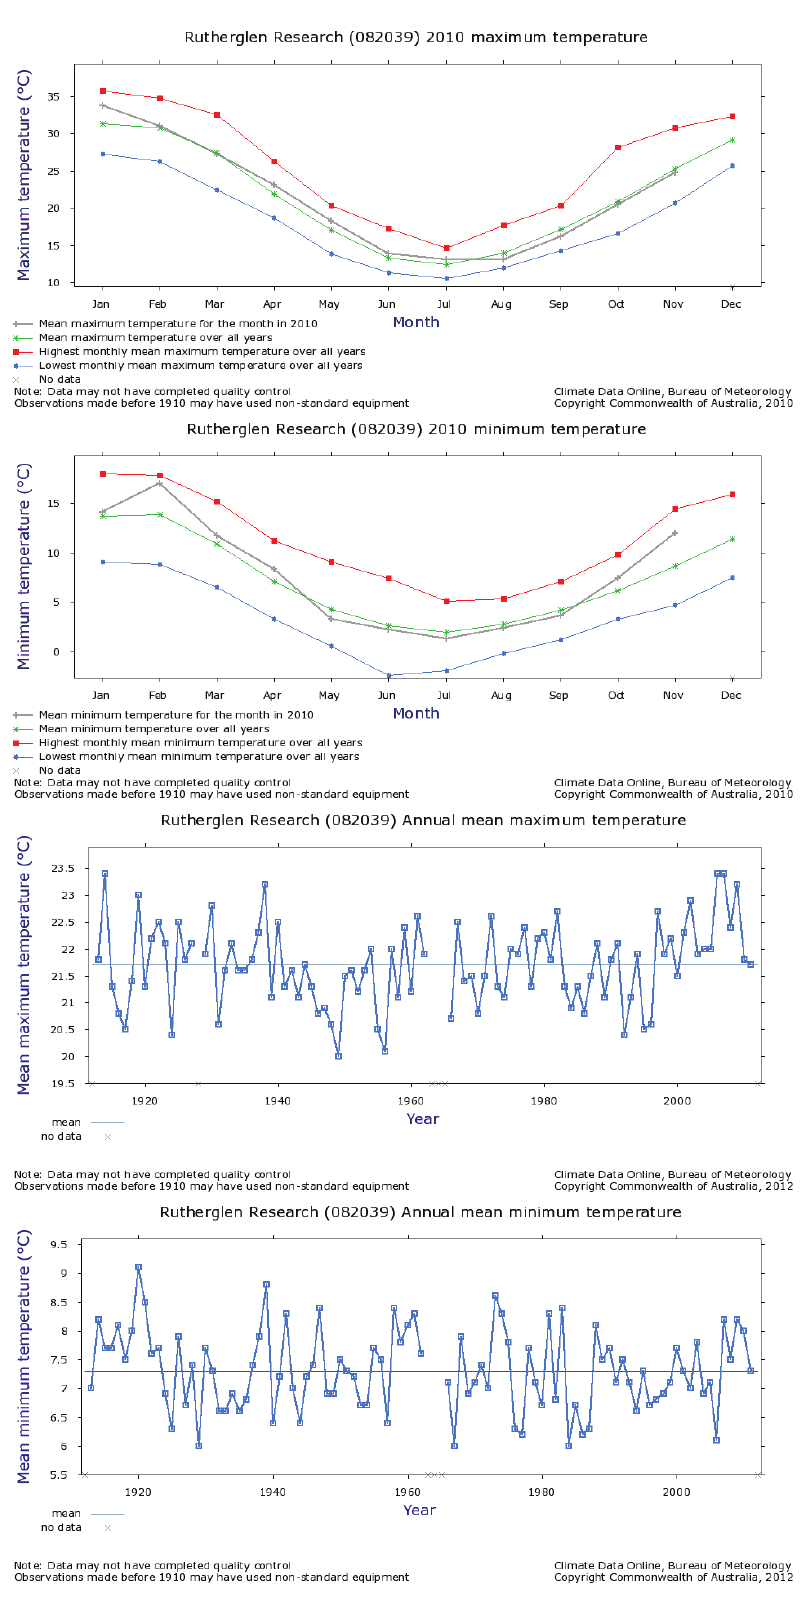
Figure 9. Australian Government Bureau of Meteorology temperature graphs for historical locations in Victoria, Aus-